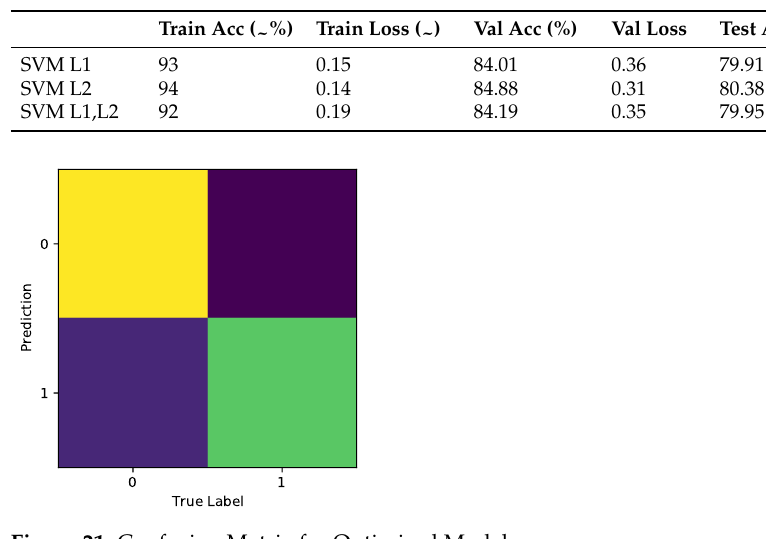
Figure 21. Confusion Matrix for Optimised